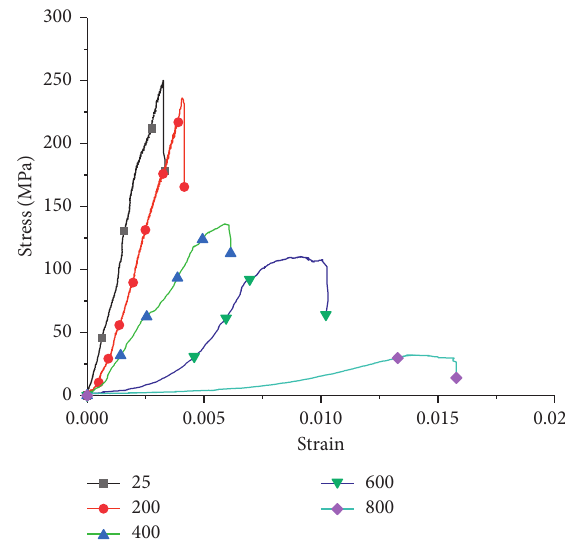
Figure 7: Stress-strain curve of uniaxial compression test (water